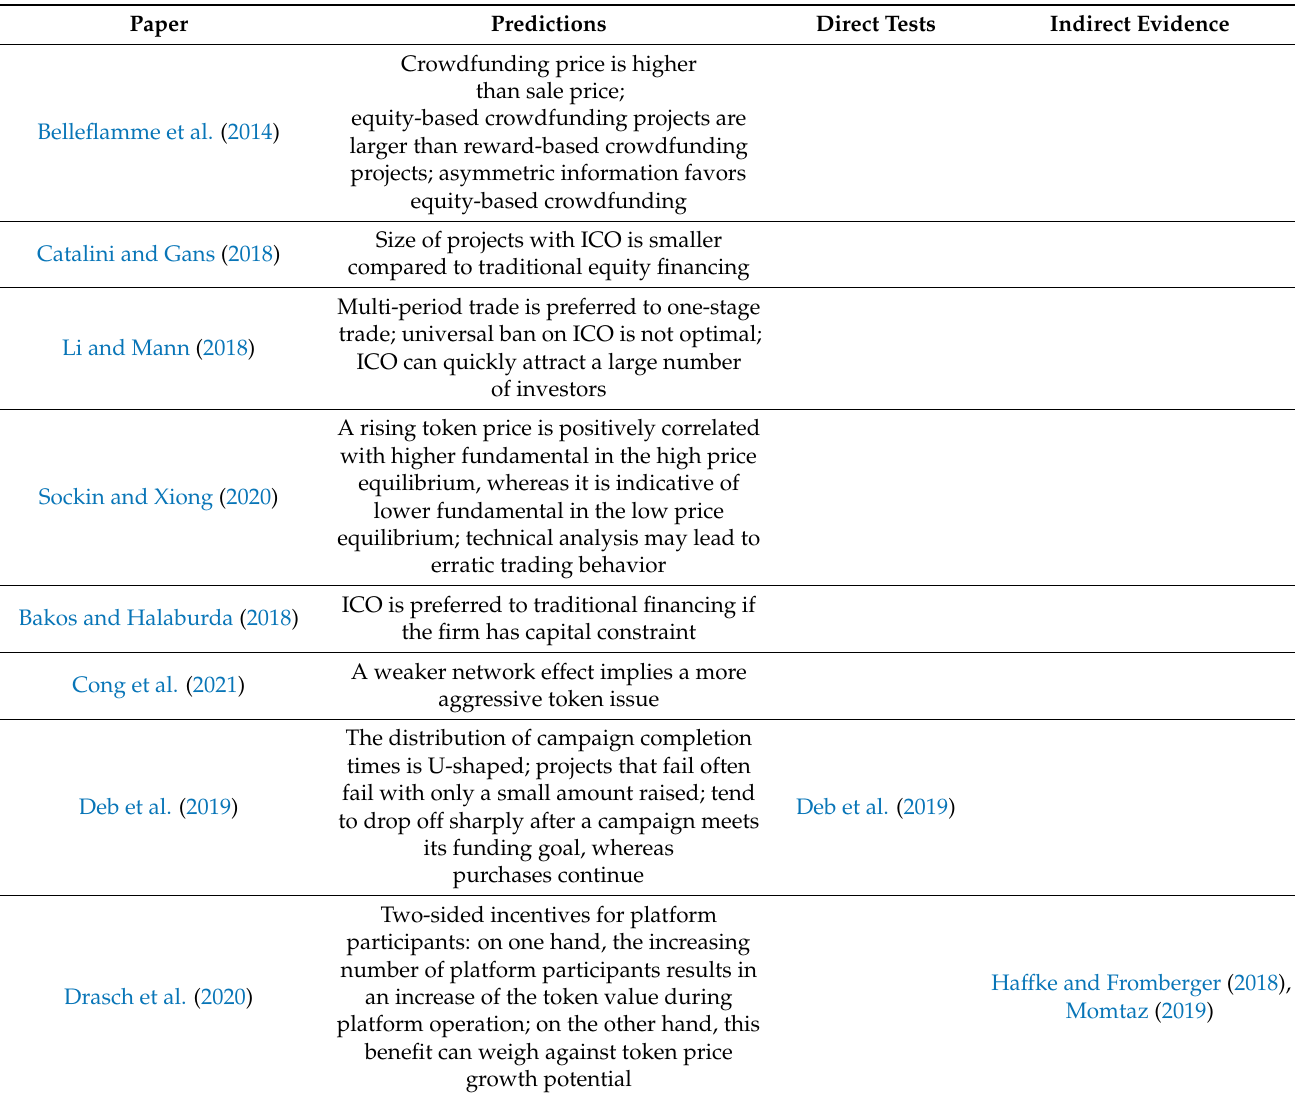
Table 5. Network benefit theories of crowdfunding and token